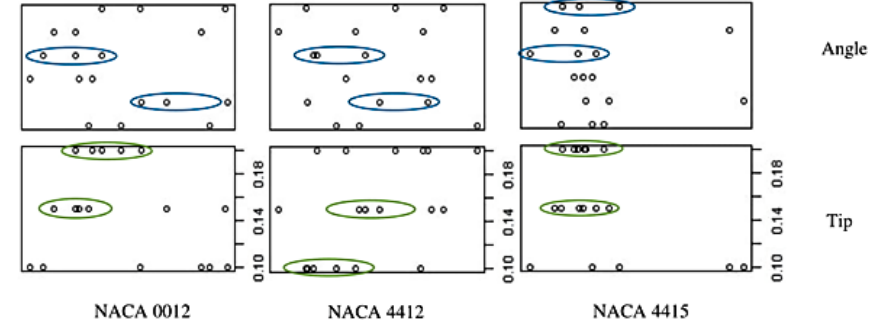
Figure 21. Dependent variables with list of coefficients for three airfoils. Table 9. Dependent variables with list of coefficients for three